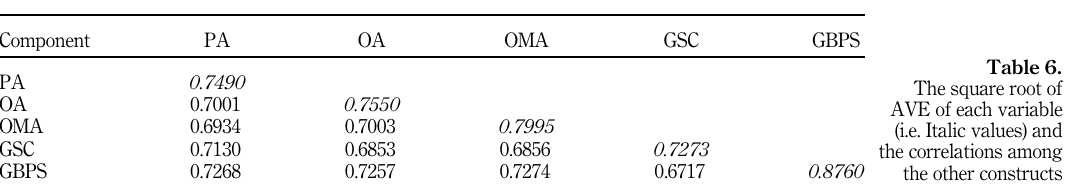
Table 6. The square root of AVE of each variable (i.e. Italic values)